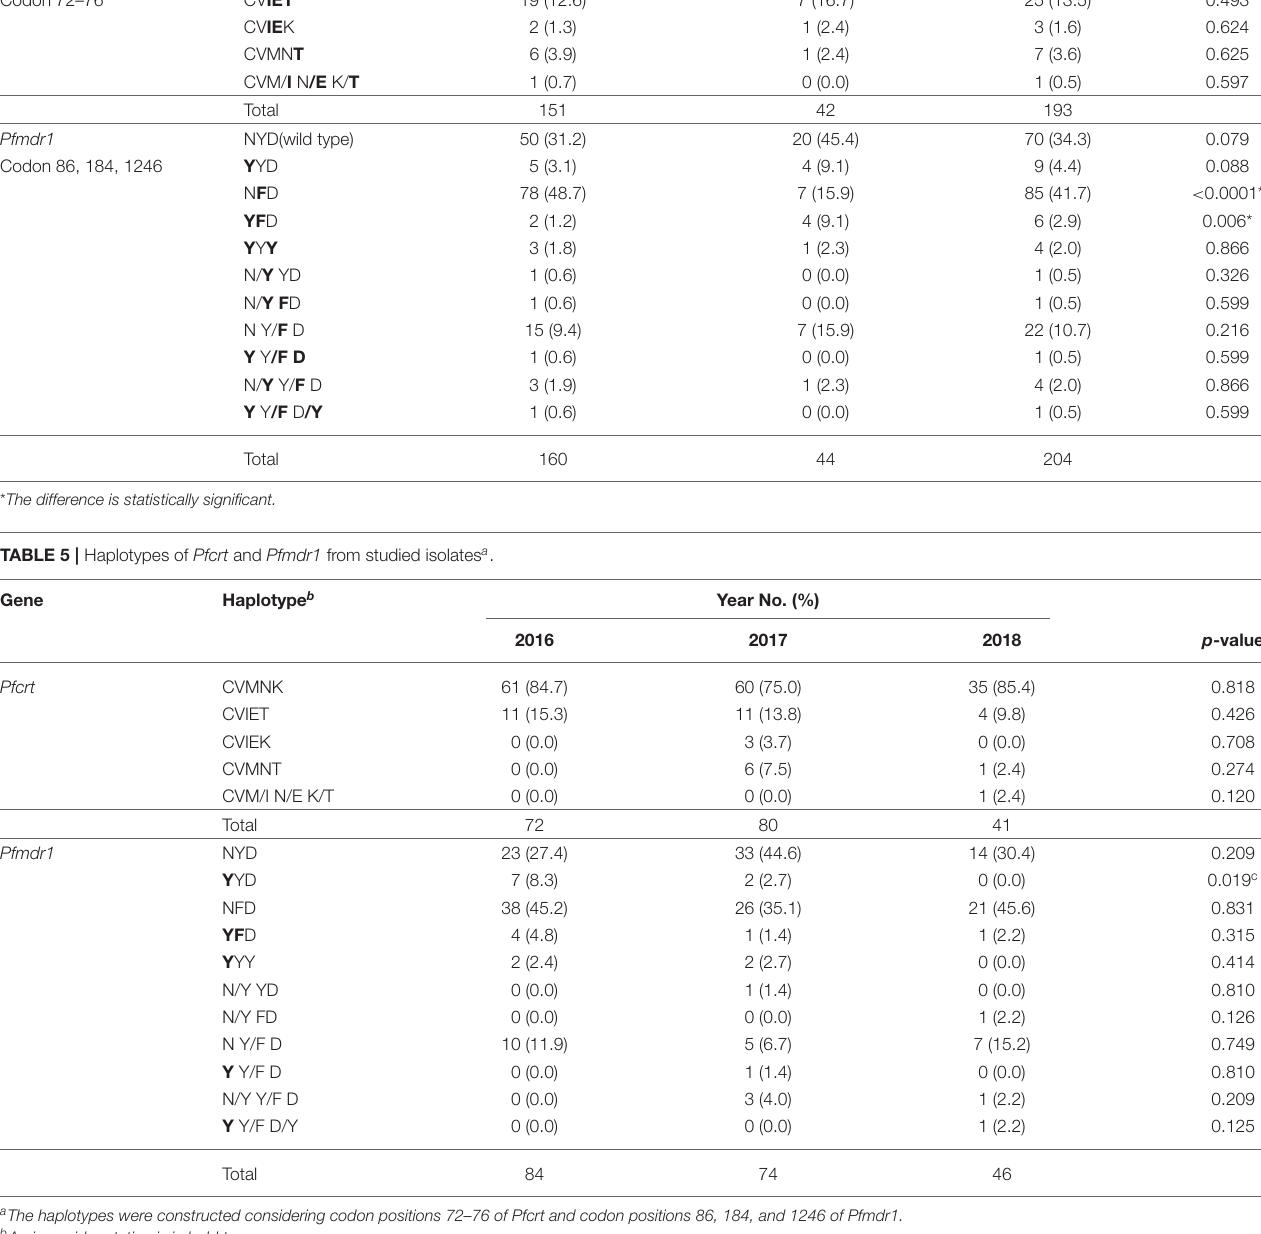
a The haplotypes were constructed considering codon positions 72–76 of Pfcrt and codon positions 86, 184, and 1246 of Pfmdr1. b Amino acid mutation is in bold type. c The difference is statistically